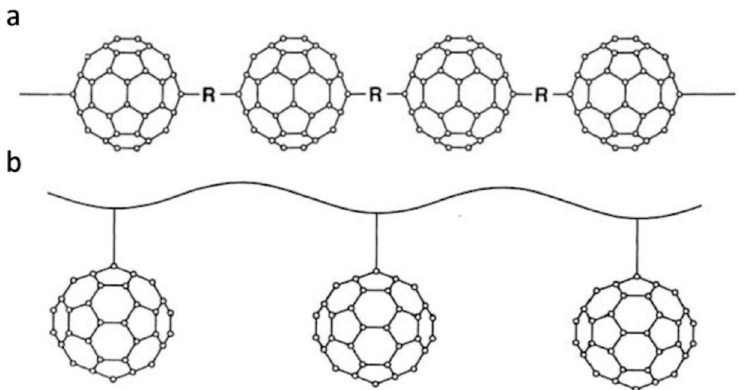
Figure 1. Schematic illustration of ( a ) pearl necklace polymer, ( b ) charm bracelet polymer. Adapted from [7].